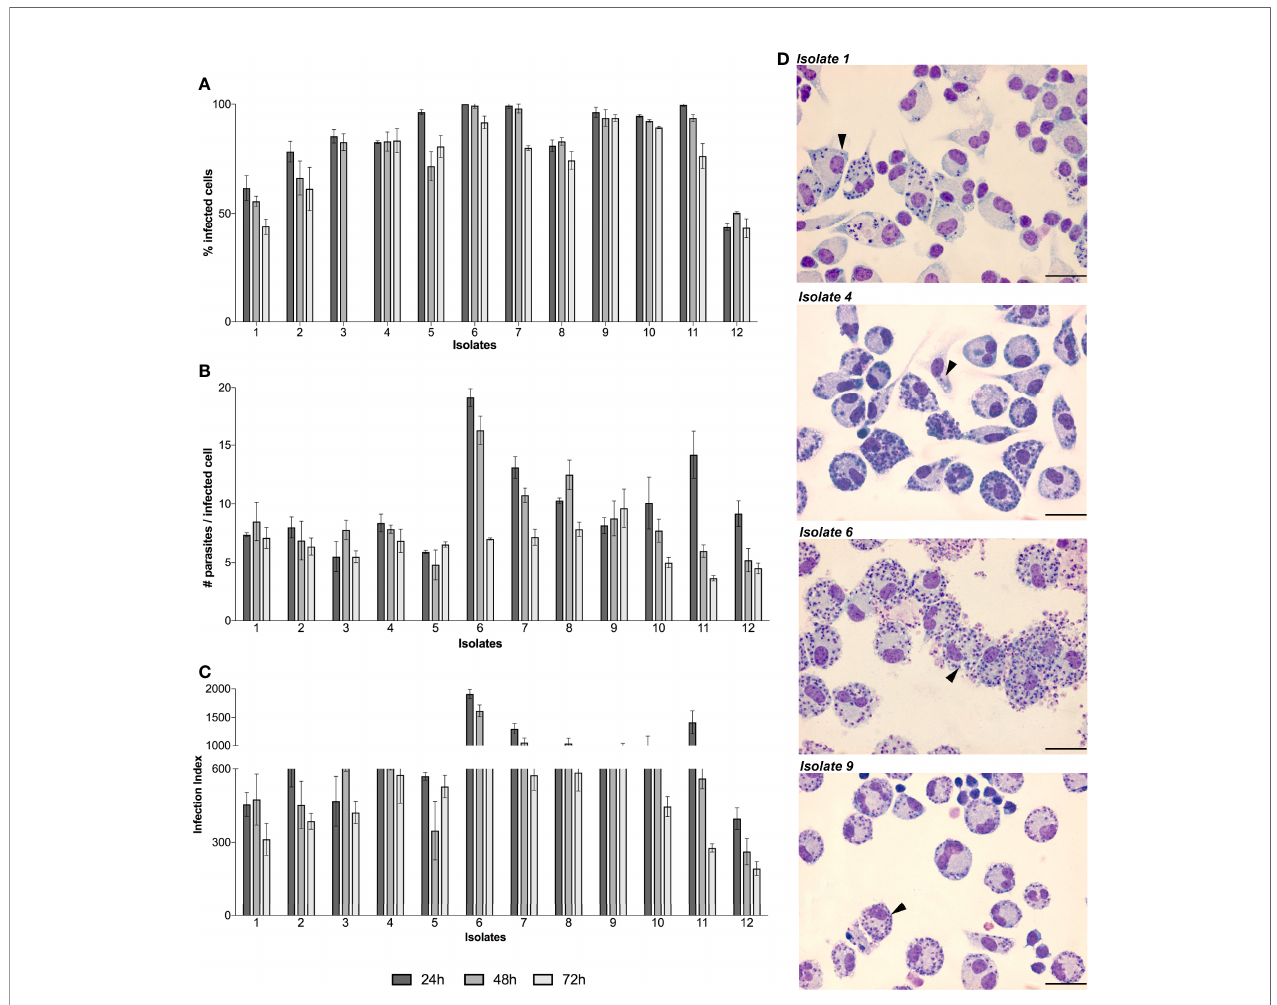
FIGURE 2 | In vitro infectivity of L. (V.) braziliensis clinical isolates. BALB/c peritoneal macrophages were infected with stationary-phase promastigotes of each isolate (n=12) in a ratio of 1:5 (macrophage:parasites). The infection kinetics was followed by counting and calculating the percentage of infected cells (A) and number of parasites inside each infected cell (B) . To determine the overall parasite load, the infection index (C) was calculated by multiplying individual data from (A, B) . The values are representative of the mean and standard deviation of three independent experiments. Light microscopy images of Giemsa-stained macrophages infected by isolates 1, 4, 6 and 9 are showed as representative of all infections, black arrows indicate intracellular amastigotes and scale bars correspond to 100 µm in each image (D)